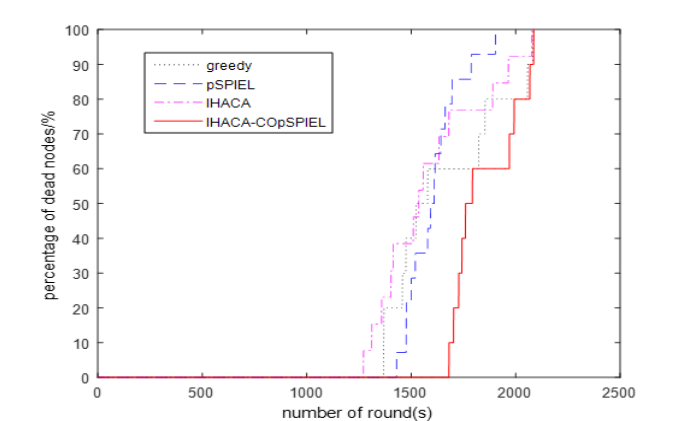
Figure 3. Comparison of the percentage of dead nodes in the four algorithms.